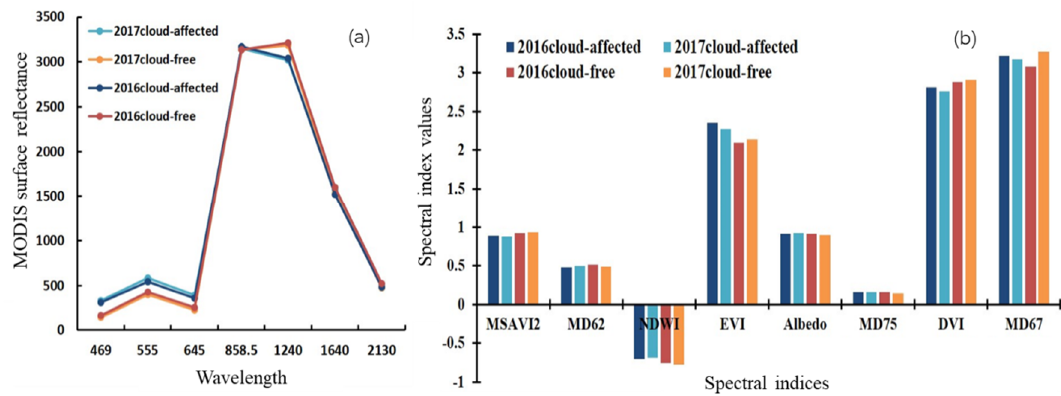
Figure 8. The impacts of cloud contamination on ( a ) spectral signatures and ( b ) spectral indices from the 2016 and 2017 MODIS data. Note: In order to keep all spectral indices in the same data range between −1 and 1, the albedo and the difference vegetation index values were divided by 10,000 and 1000, respectively.